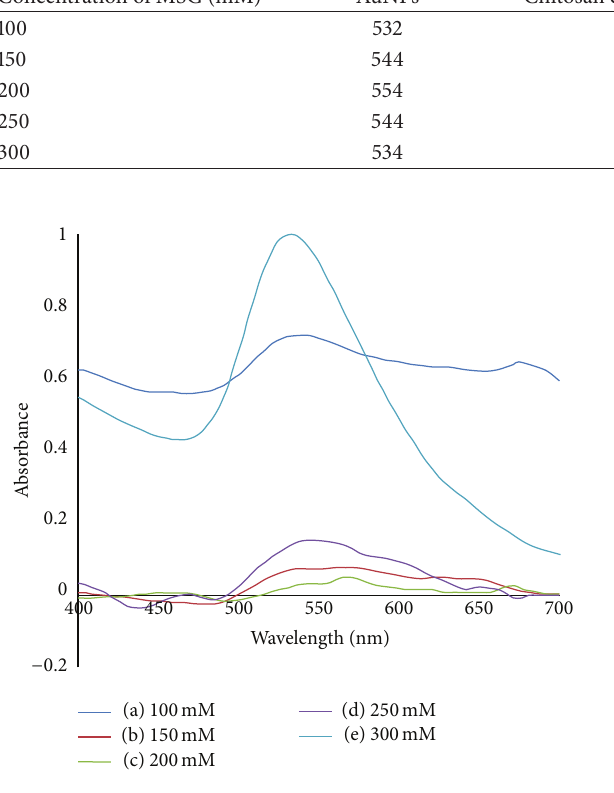
Figure 8: Absorption spectra of AuNPs with various concentrations of reducing agent MSG after 1 month aging time: (a) 100 mM; (b) 150 mM; (c) 200 mM; (d) 250 mM; (e) 300 mM.